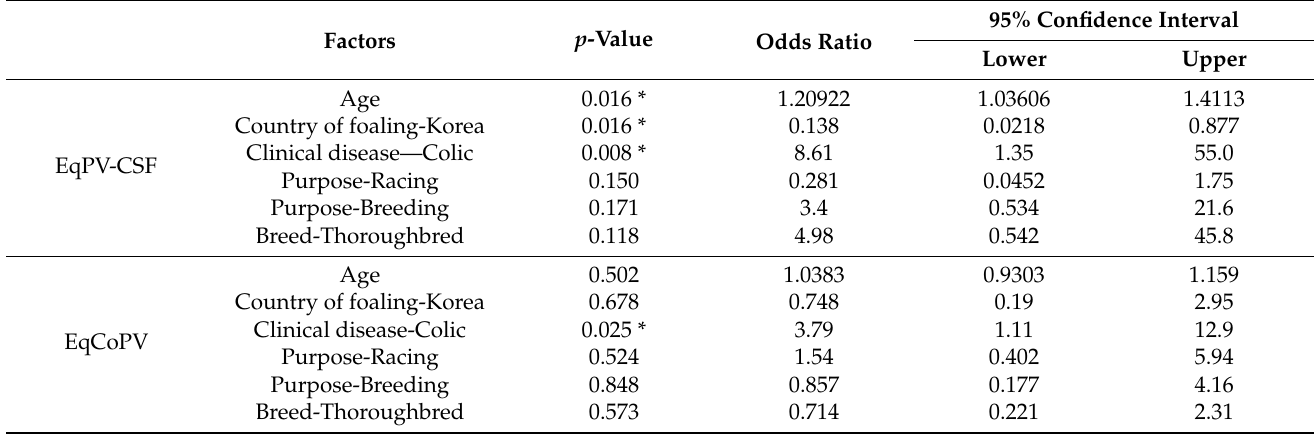
Table 3. Statistical analysis of potential risk factors for equine parvovirus